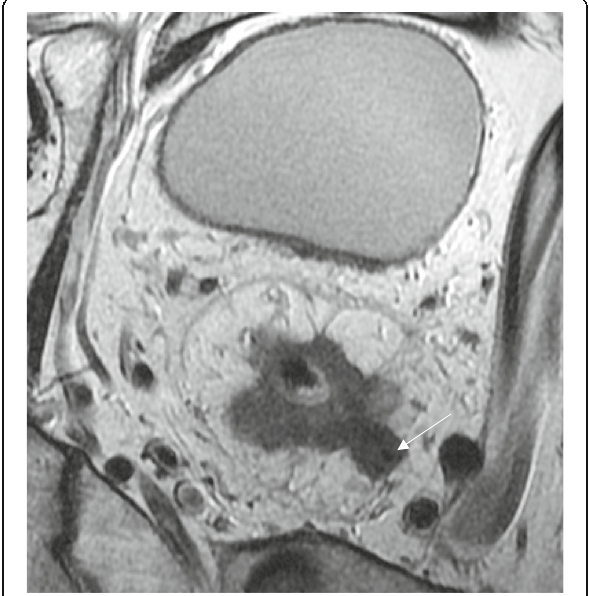
Fig. 5 Extramural vascular invasion. High-resolution axial T2WI shows an annular tumor infiltrating the mesorectal fat. A mesorectal vessel flow void (arrow) is involved by nodular extension of tumoral signal intensity beyond the muscularis